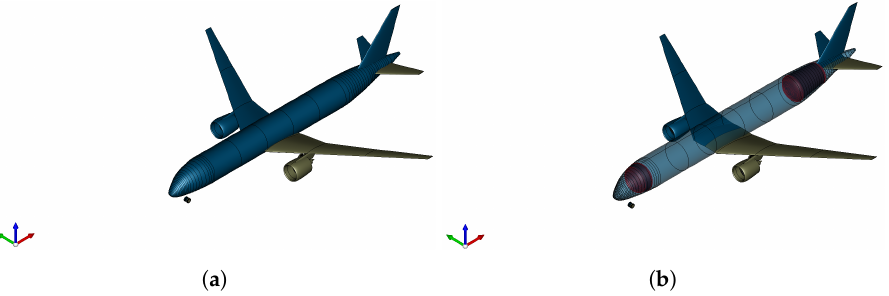
Figure 9. Isometric view of 2040 Kerosene D261+SAF ( a ) and LH2 concept D261+H2 ( b ).